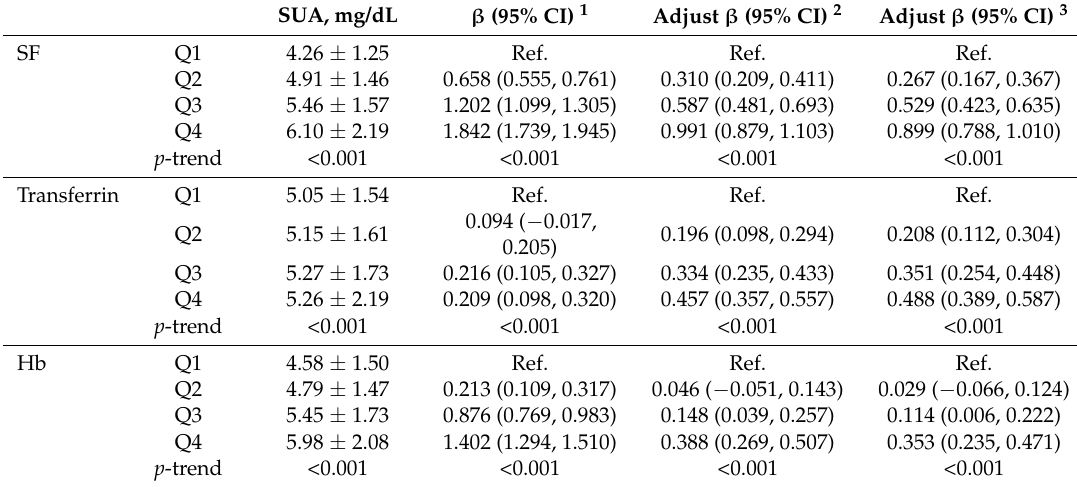
Table 2. Multilevel-adjusted associations of SF, transferrin, and Hb levels with SUA concentrations in Chinese adult population ( n =